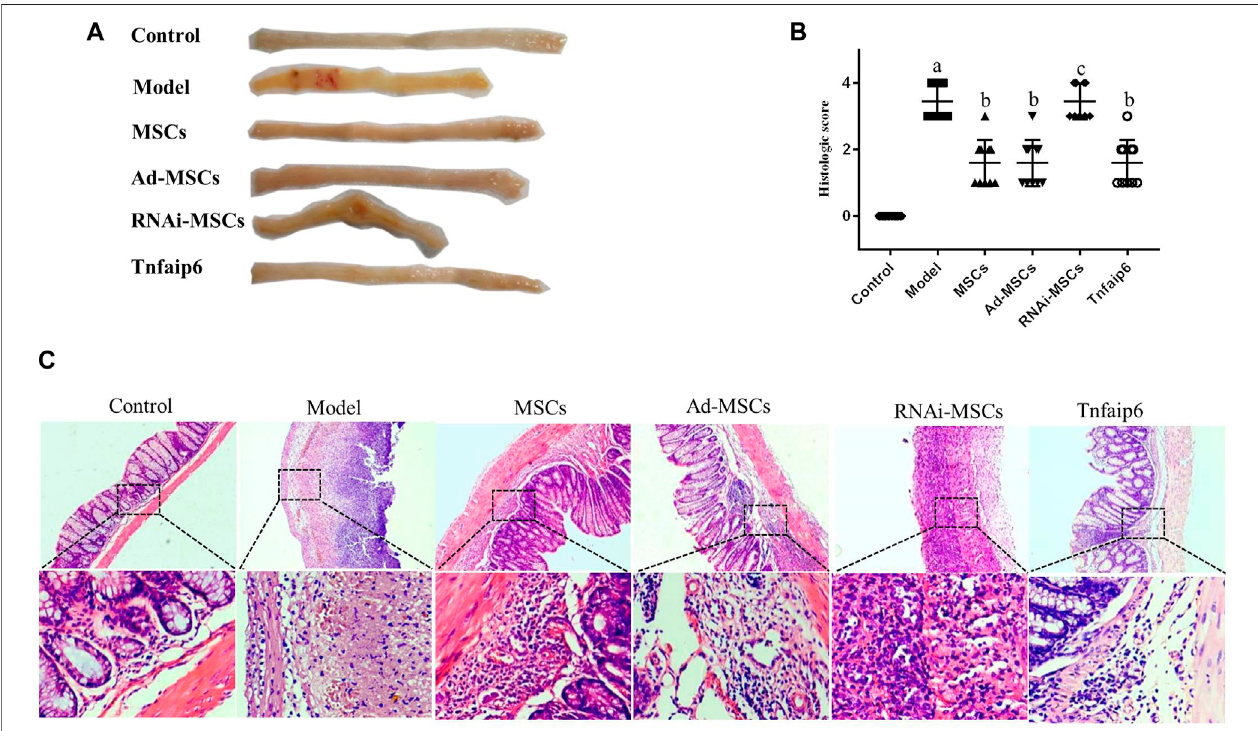
FIGURE 6 | MSCs or Tnfaip6 ameliorates histological changes in TNBS-induced colitis in mice. (A) Colon tissue injury in each group: obvious ulcers and mucosal bleeding in the model and RNAi-MSCs groups, no visible lesions in other groups. (B) In fl ammation-related histologic scores. (C) Representative HE-stained images of colon sections ( × 40 and × 200 magni fi cation). Control group: normal colon; model and RNAi-MSCs group: in fi ltrating in fl ammatory cells, increased vascular density and